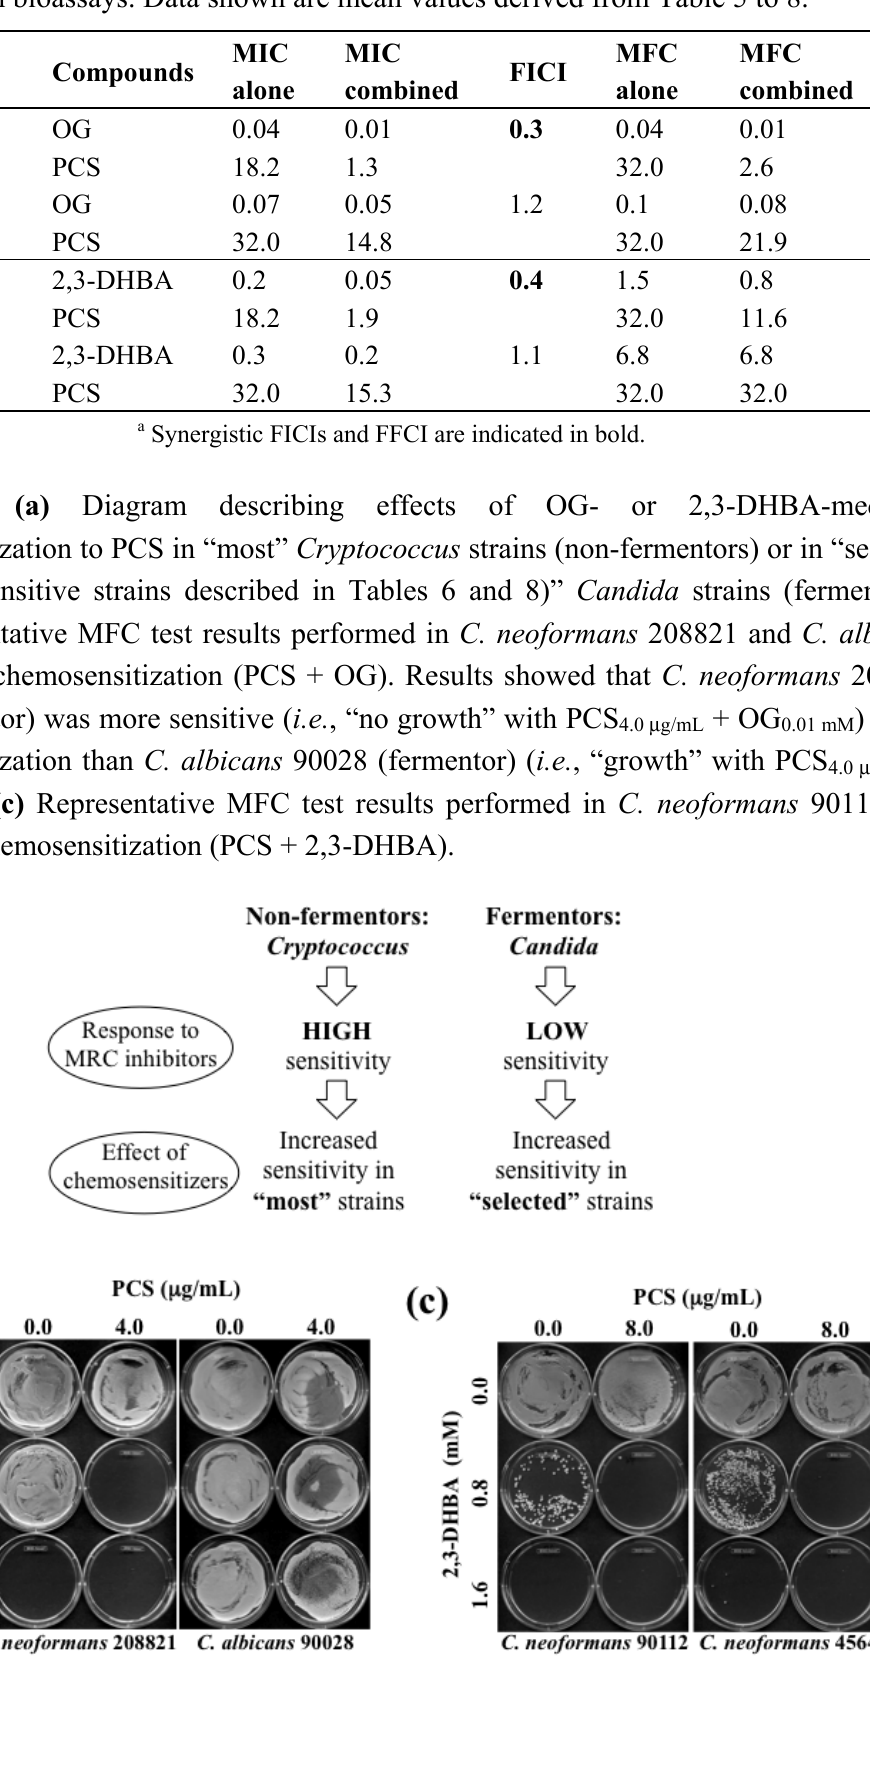
Table 9. SUMMARY: Antifungal chemosensitization of OG or 2,3-DHBA (mM) to PCS ( μ g/mL) tested against Cryptococcus or Candida strains determined by EUCAST-based microdilution bioassays. Data shown are mean values derived from Table 5 to 8. a